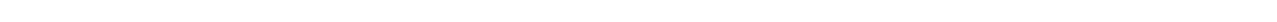
Fig. 2 MT occupancy controls inter-KT stretching. a Schematic of human KTs showing relative positions of GFP-CENPA (green) and Ndc80 (9G3, red). b Immuno fl uorescence images of hTert-RPE1 GFP-CENPA cells (green) treated with DMSO or 15 nM BAL27862 stained for Ndc80 (red). Insets illustrate sub-pixel localization of GFP (green crosses) and Ndc80 (red crosses). Scale bars = 2 μ m for merged images, 500 nm for insets. c Schematic of inter- and intra-KT distances and swivel measurements. d Quanti fi cation of in fl ation-corrected 3D intra-KT distances for cells treated with DMSO or 15 nM BAL27862. N = 4, n = 2251 – 2507 KTs, p = 0.013 in two-tailed z -test. Values given are means ± s.e.m. e Swivel ranges for KTs in cells treated with DMSO (black), or 15 nM BAL27862 (red). Values given are s.d., N = 4; n = 1952 – 2263 sister-KT pairs. f Autocorrelation curves of sister-KT pairs of cells treated with DMSO (black), 12 nM BAL27862 (red), or 1 μ g ml − 1 nocodazole (blue); yellow is 95% CI for BAL27862-treated cells; n = 770-880 sister-KT pairs; N = test). h Resting inter-KT distances measured in cells co-treated with 1 μ g ml − 1 nocodazole and either DMSO (black, n = 289) or 12 nM BAL27862 (red, n